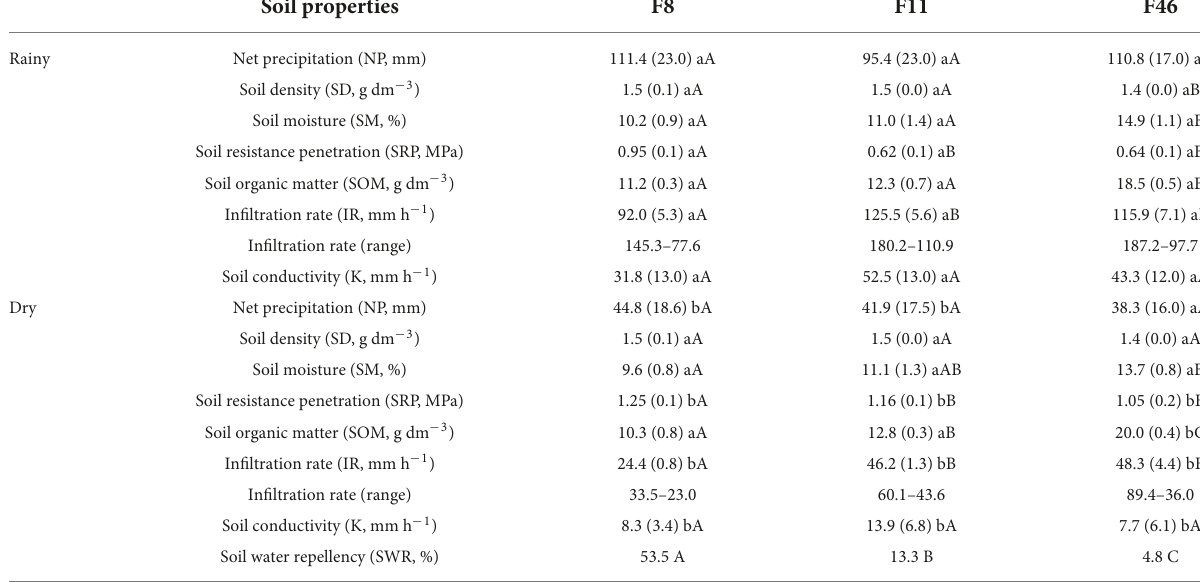
TABLE 2 Soil properties’ seasonality for initial (F8, F11) and advanced (F46) passive restoration